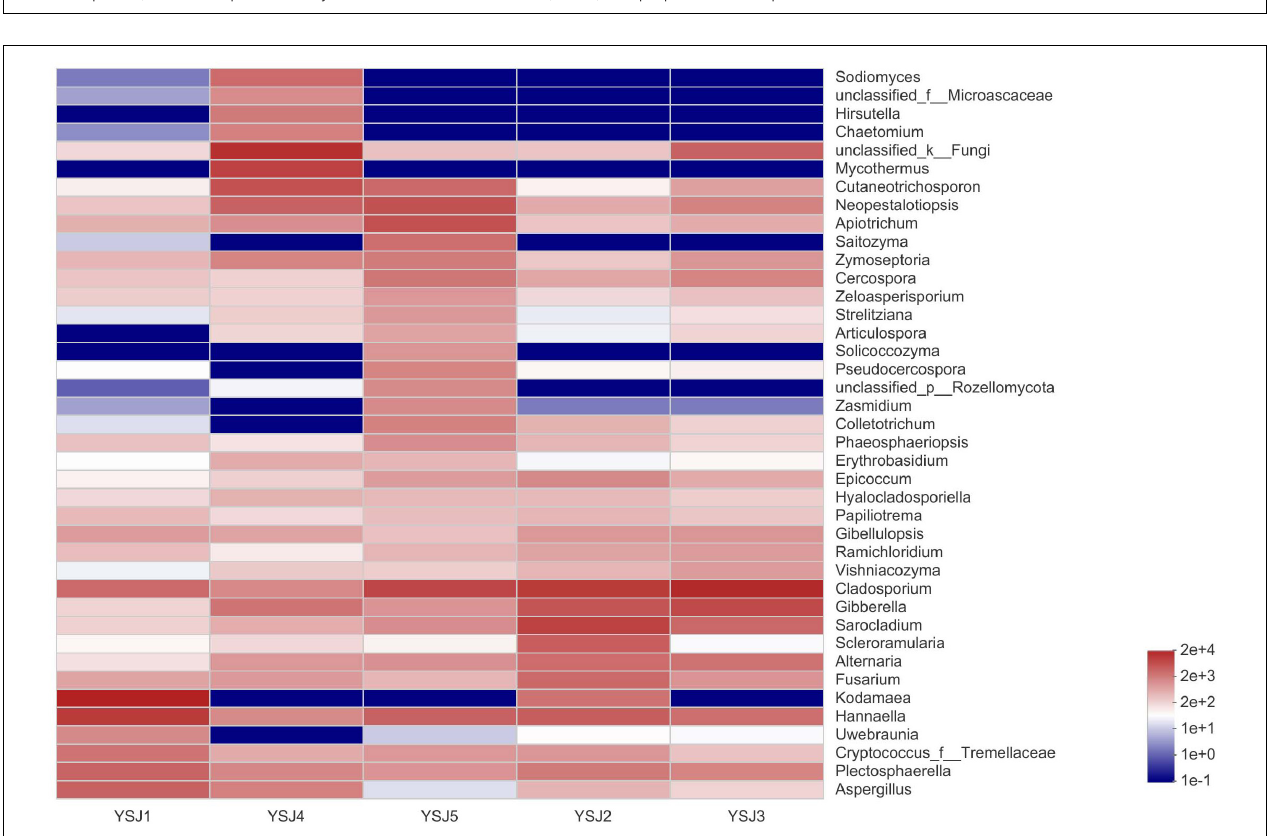
Frontiers in Microbiology |